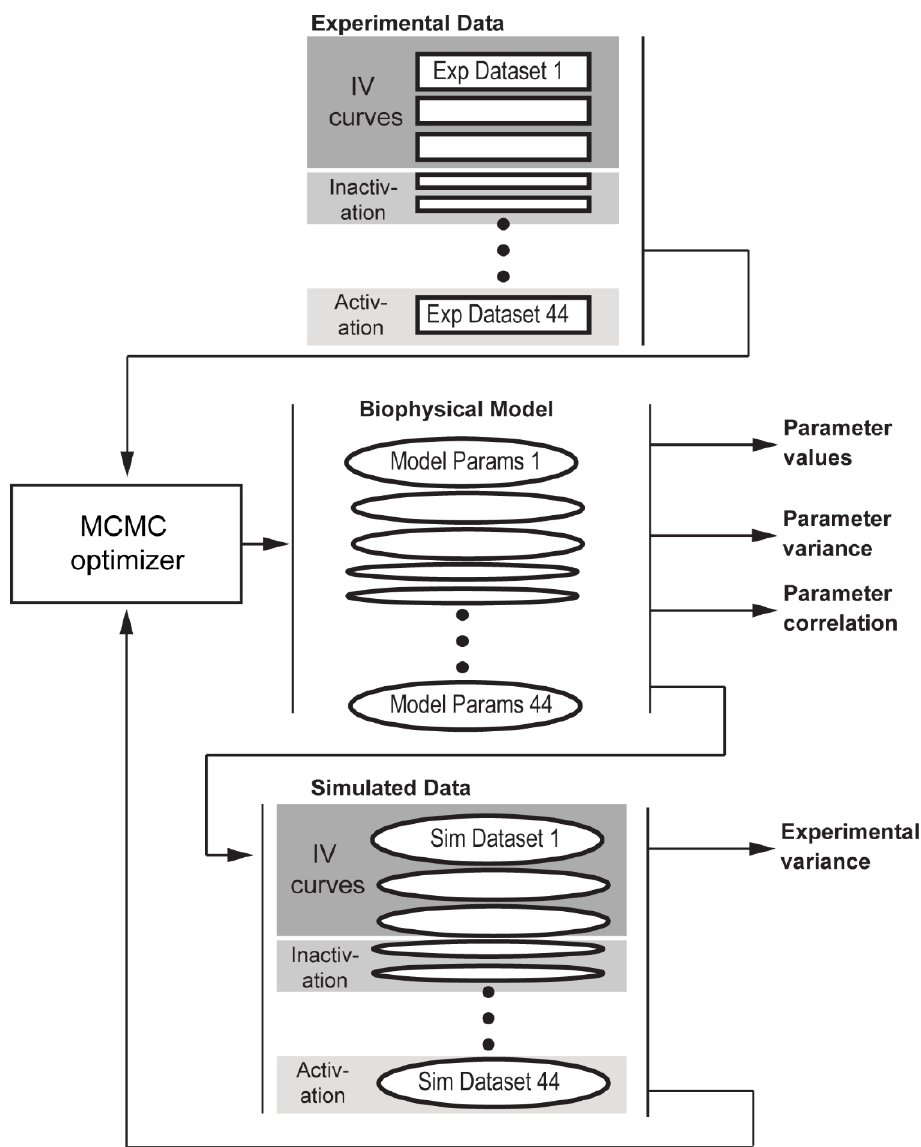
Figure 2. Statistical approach for fitting model parameters. Schematic illustrating the workflow used to fit biophysical model parameters using multiple sources of data. Experimental Data on voltage-gated Na + channel measurements in human atrial cells are curated and provided as input to the statistical model fitting procedure [Monte Carlo Markov Chain (MCMC) optimizer)]. A subset of the data are held back for validation. The MCMC fitting procedure generates an initial guess for the set of parameters corresponding to each dataset, which are fed to the biophysical model to generate a set of simulated results . Independent normal variables with means of simulated results are compared to experimental data in the model to update the model fit while experimental variances encompass the variability between the predictions and experimental results and is used to track goodness of fit. Finally, the Parameter Variance and Parameter Correlation capture the variability between different experiments and the relationships between different